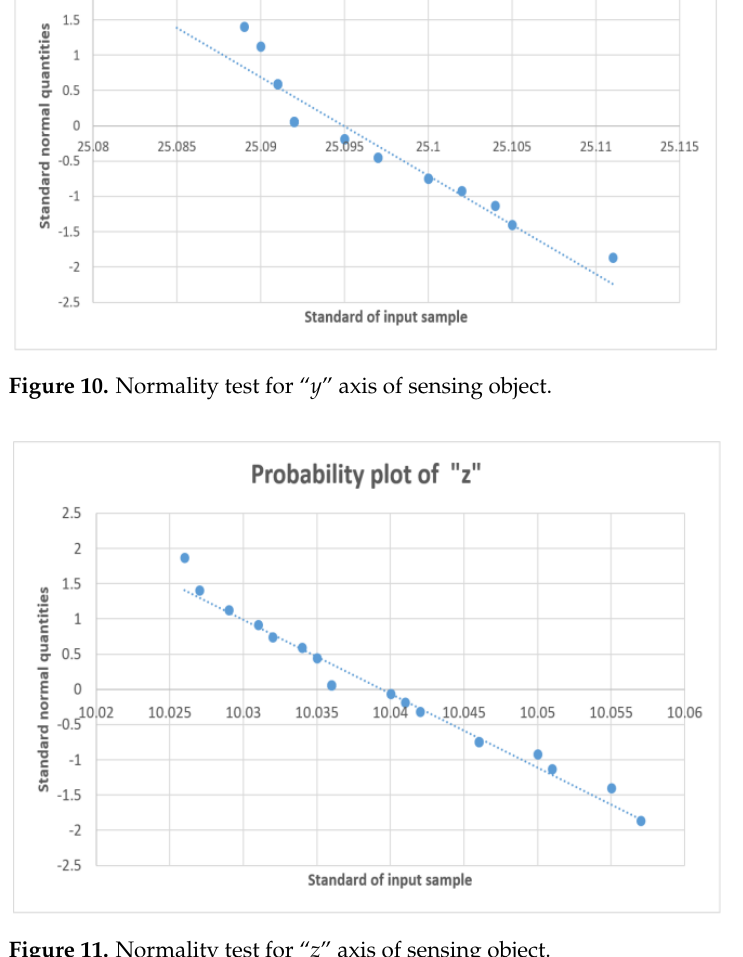
Figure 11. Normality test for “ z ” axis of sensing object.